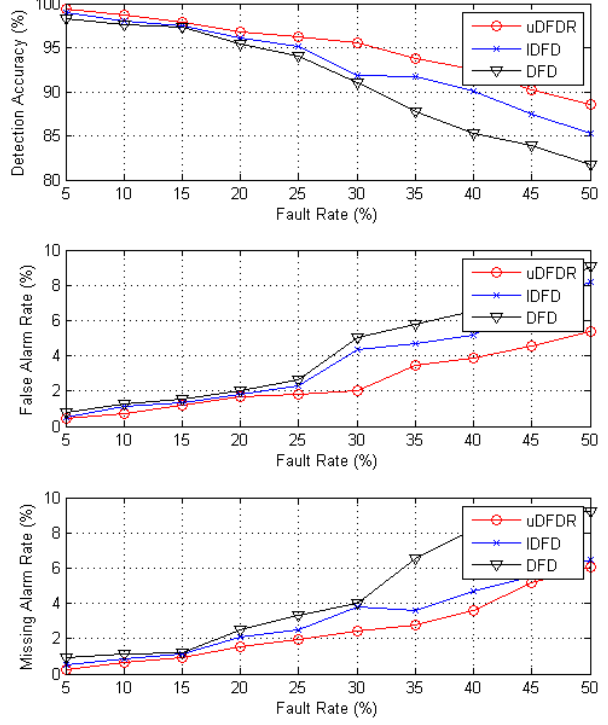
Figure 8. Detection effects under 120 working node